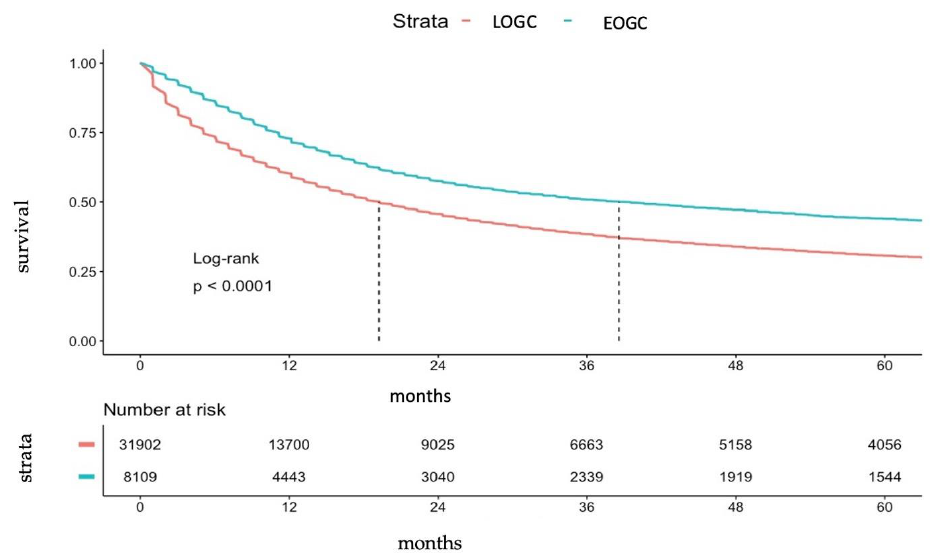
Figure 4. Kaplan-Meier-Curve for survival for EOGC and LOGC.